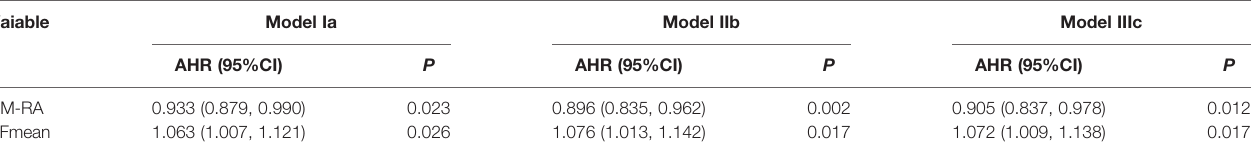
SM-RA, Skeletal muscle radiation attenuation; HAIC, hepatic artery infusion chemotherapy; AHR, adjusted hazard ratio; CI, con fi dence interval; VFmean, Mean CT value of visceral fat. a Before adjusted for other variables. b Adjusted for gender and age. c Additionally adjusted for